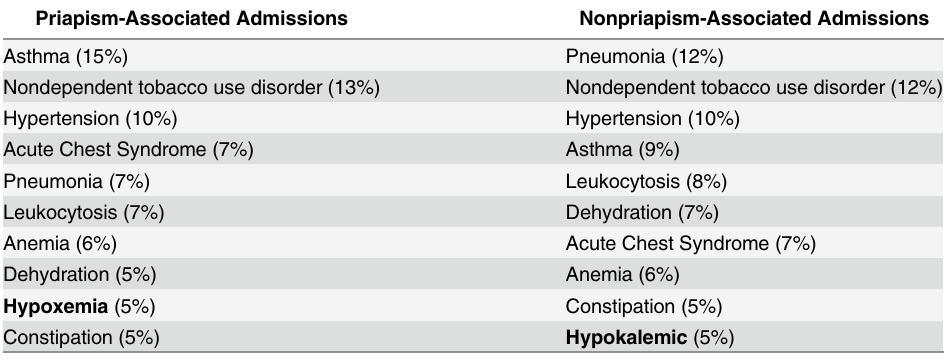
Table 3. The 10 most frequently co-occurring conditions based on International Classification of Dis- eases , 9 th Revision , Clinical Modification codes resulting in hospital admission from the ED among patients with sickle cell disease by priapism